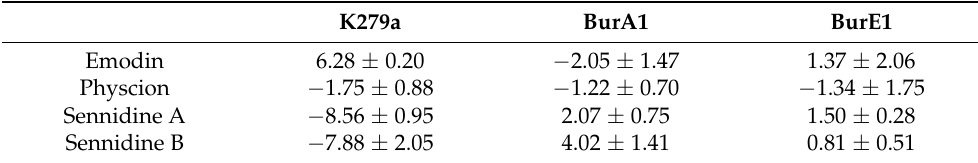
Table 5. Levels by which emodin, physcion, sennidine A, and sennidine B (30 µ g/mL) inhibited bacterial growth, expressed as a percentage (%) and based on bacterial growth in the negative control (dimethyl sulfoxide, 0.5%). K279a BurA1 BurE1